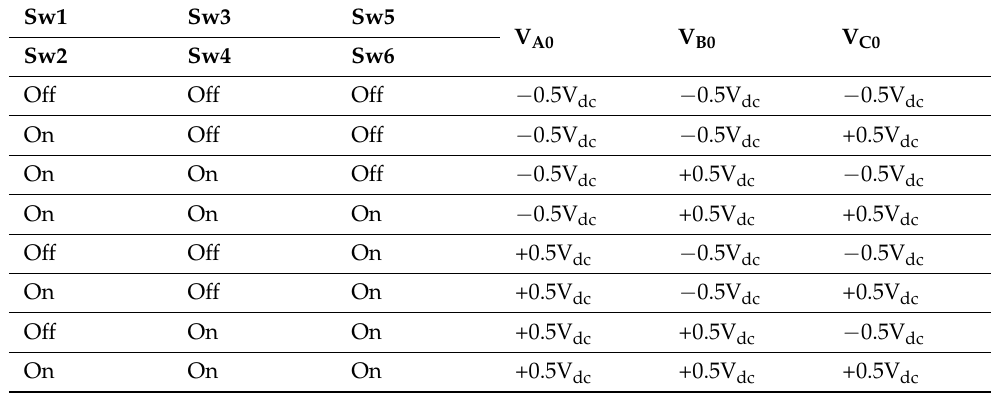
Table 1. Inverter switching logics.